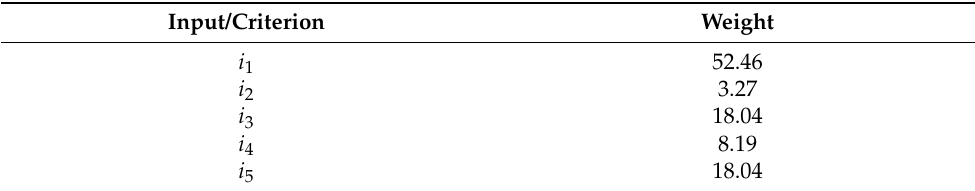
Table 4. Input weights for z = 16.